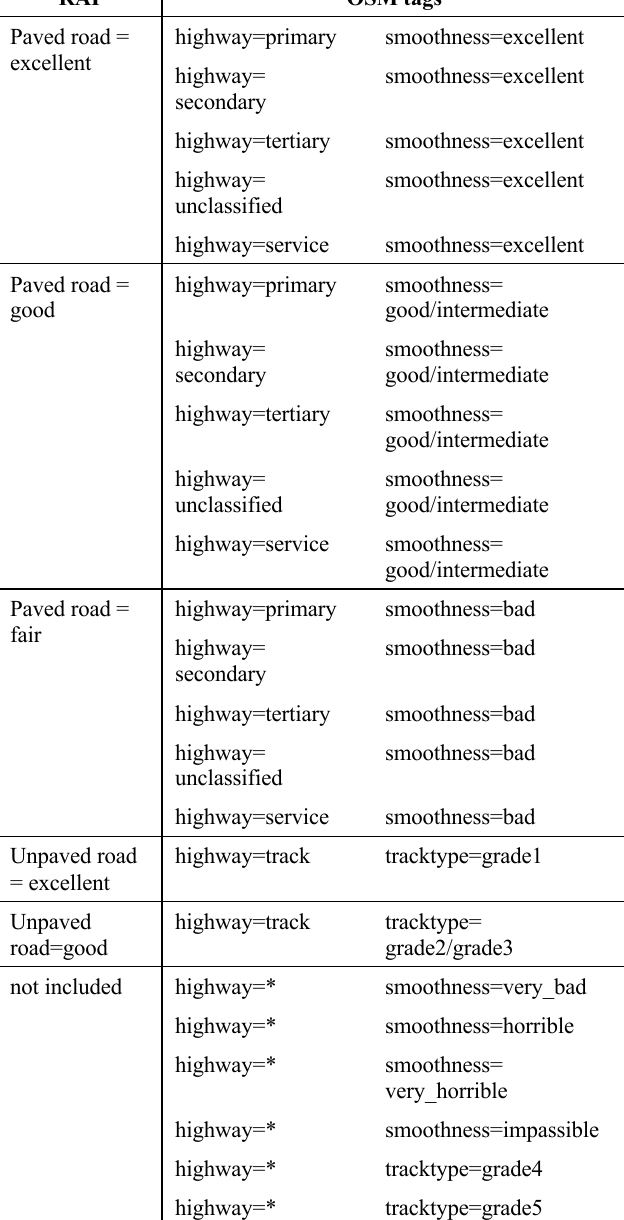
Table 1. Mapping from OSM tags to the World Bank’s description of road conditions